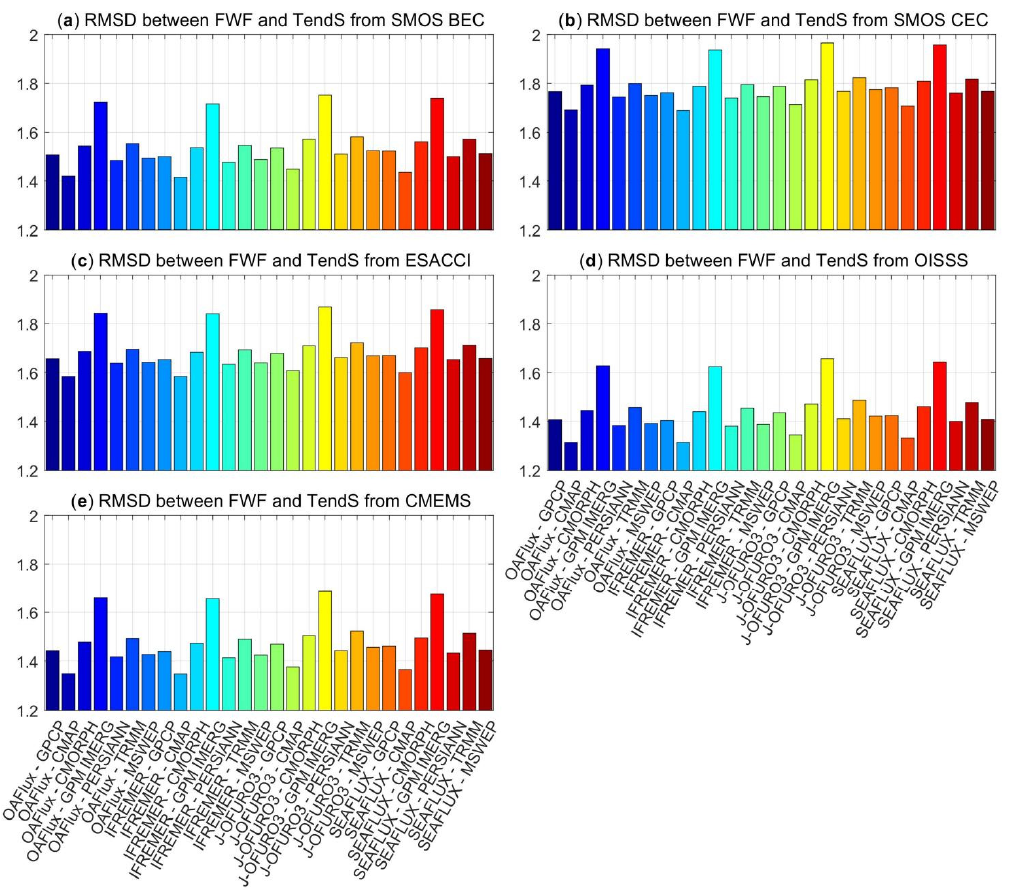
Figure 10. Area-weighted RMSD between 28 sets of FWF and SSS tendencies based on ( a ) SMOS BEC, ( b ) SMOS CEC, ( c ) EAS CCI, ( d ) OISSS and ( e ) CMEMS over 50°S–50°N from 2012–2017. The units for RMSD are g/kg/year. From dark blue to light blue bars indicate combinations between OAFlux and seven precipitation datasets; from cyan to bright green bars denote combinations between IFREMER and seven precipitation datasets; from light green to orange bars indicate combinations between J-OFURO3 and seven precipitation datasets; and from light red to dark red bars represent combinations between SEAFLUX and seven precipitation datasets. Figure 11 examines the difference in RMSD between SSS tendency and FWF on seasonal and nonseasonal time scales among 140 sets of data from 2012 to 2017. The RMSD on the seasonal time scale is generally smaller than that on the nonseasonal time scale, except for three sets of OISSS data with FWF that show the same magnitude of RMSD on both seasonal and nonseasonal time scales. The minimum RMSD on nonseasonal time scales occurs in OISSS, with values of approximately 0.95 g/kg/year, while the minimum in seasonal RMSD occurs in CMEMS, with values of 0.9 g/kg/year. The maximum RMSD on seasonal and nonseasonal time scales occurs in SMOS CEC, with values of 1.22 g/kg/year for the former and 1.58 g/kg/year for the latter.